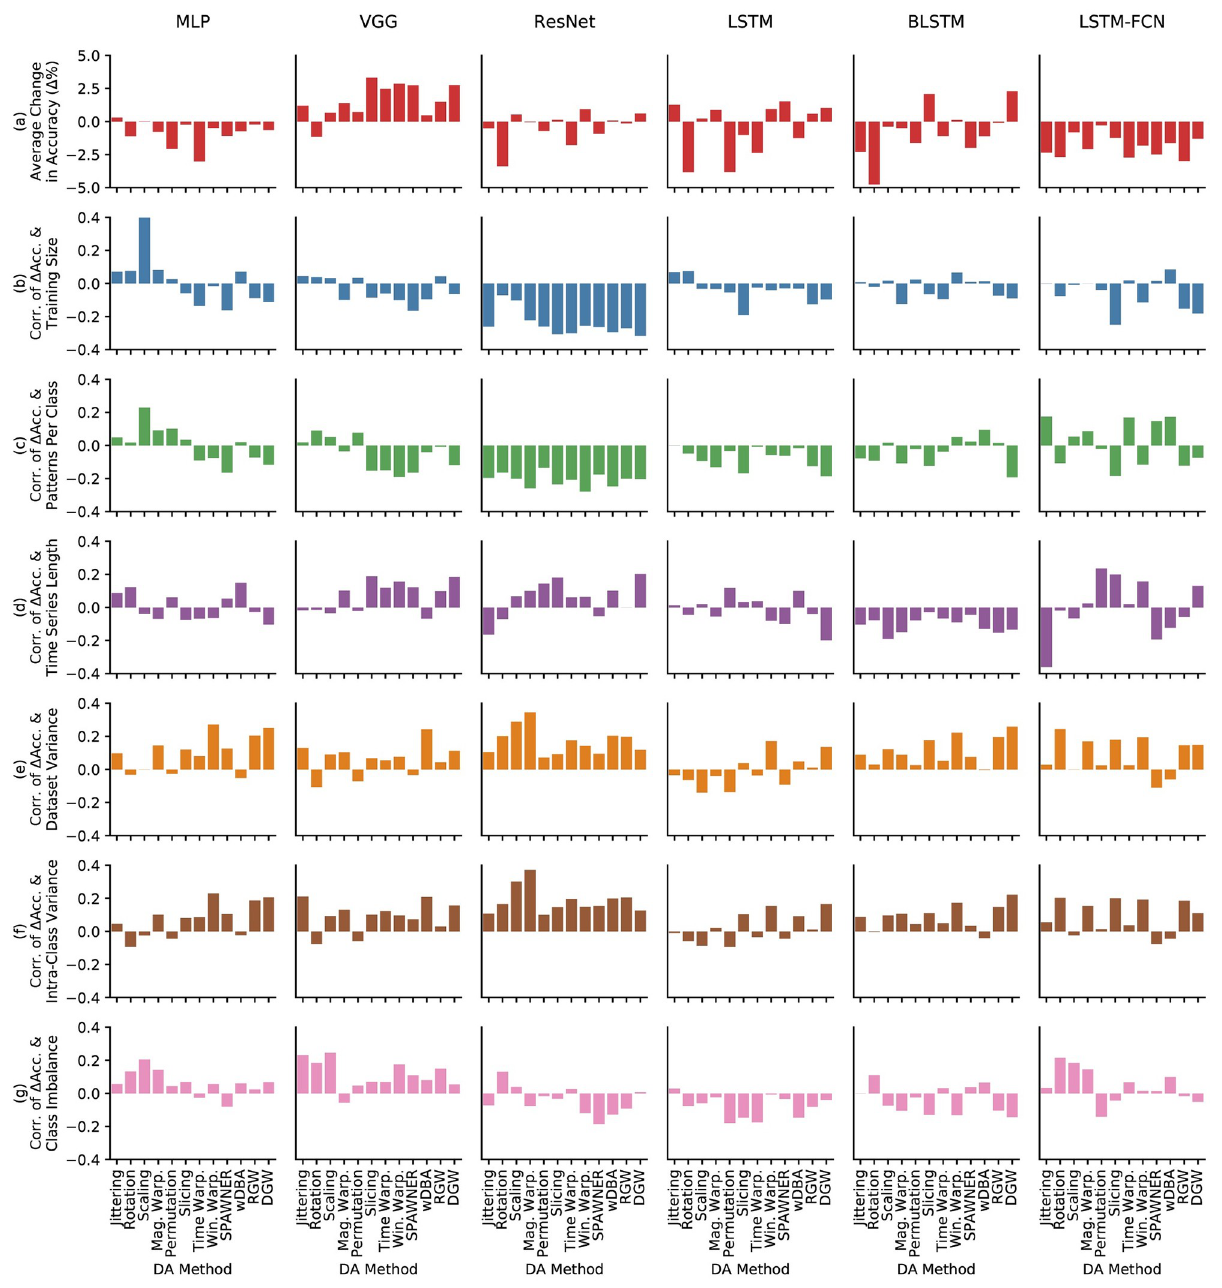
Fig 5. Spearman’s Rank Correlation Coefficients between change in accuracy ( Δ Acc) and various dataset characteristics. The top row in red is the change in accuracy and the subsequent rows are the correlations.